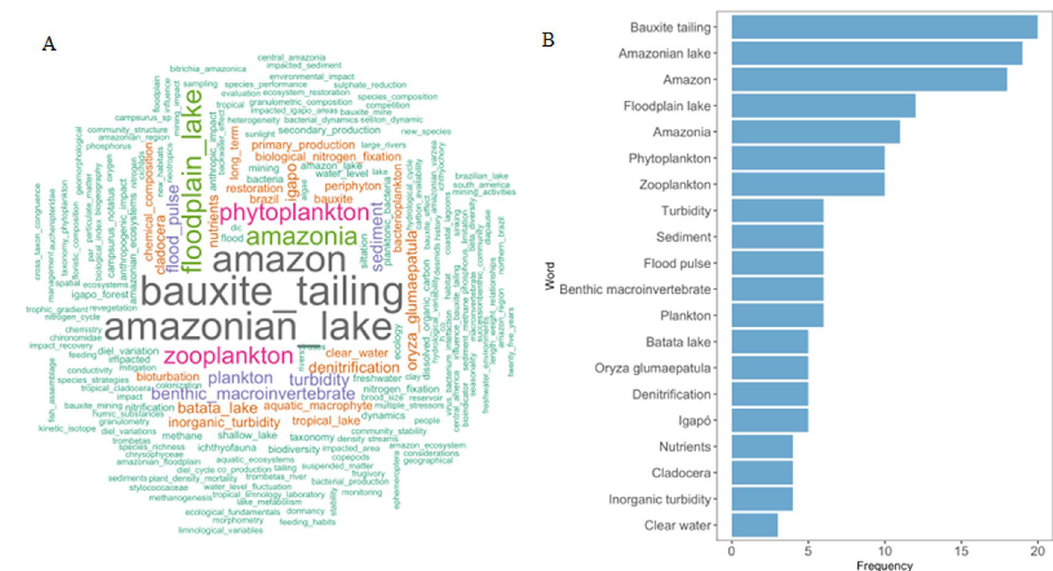
Figure 3. Word cloud representing (A) The keywords described in the papers included in the systematic review, where the font size represents the frequency of citations, and (B) Histogram with the top 20 most cited keywords.